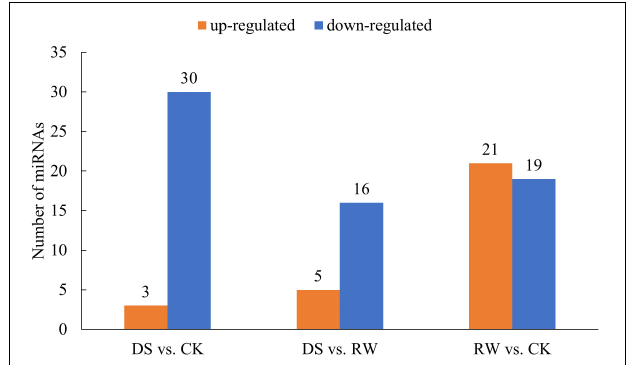
FIGURE 3 | The number of differentially expressed miRNAs for the three comparisons ( p < 0.05); orange, upregulated miRNA expression; blue, downregulated miRNA